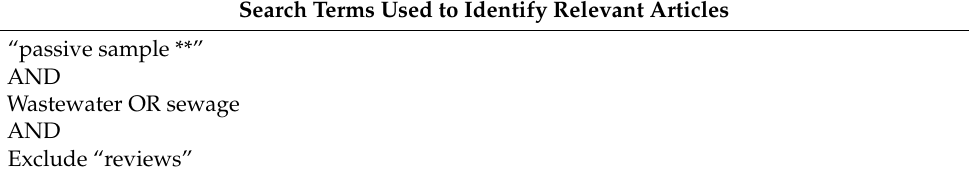
Table 1. All Keywords used to identify relevant literature on Scopus ® , Web of Science ® and Google Scholar ®